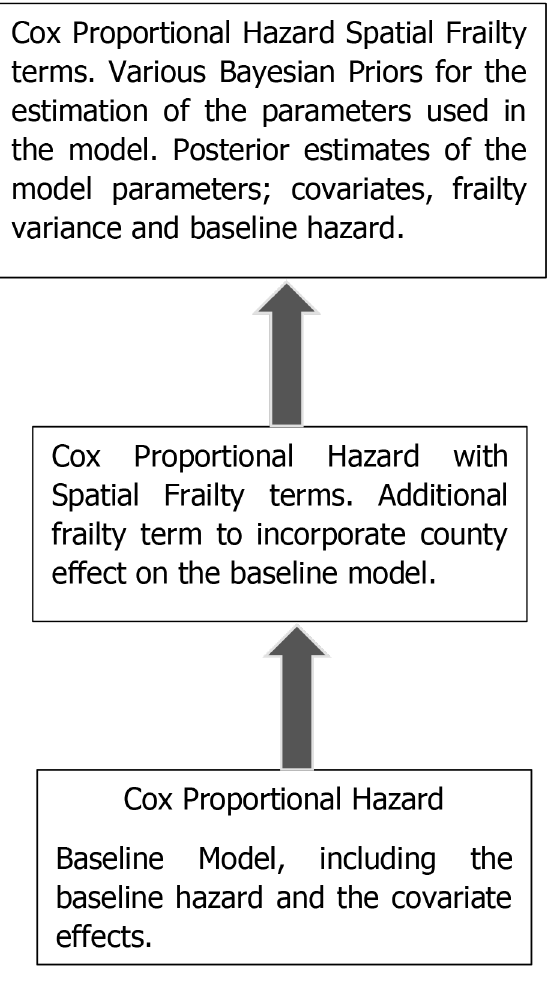
Figure A1. The model implementation